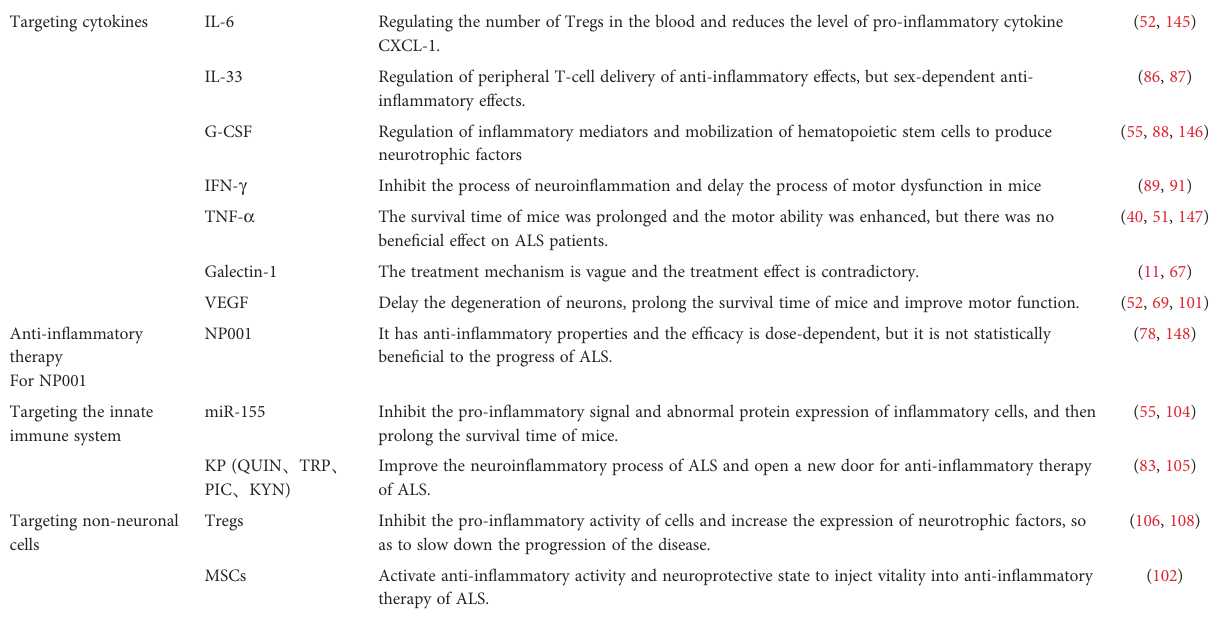
TABLE 5 Anti-in fl ammatory therapeutic strategies of ALS G-CSF, Granulocyte colony stimulating factor; IL, Interleukin; IFN- g , Interferon gamma; TNF, Tumor necrosis factor; Tregs, Regulatory T cells; VEGF, Vascular endothelial growth factor; QUIN=quinolinic acid, TRP, tryptophan, PIC, picolinic acid; KYN= kynurenine; MSCs, mesenchymal stem cells. Therapeutic